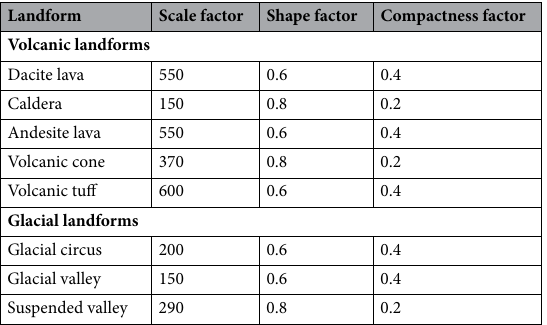
Table 3. Variations of segmentation parameters using the MRS method to detect and map volcanic and glacial landforms.